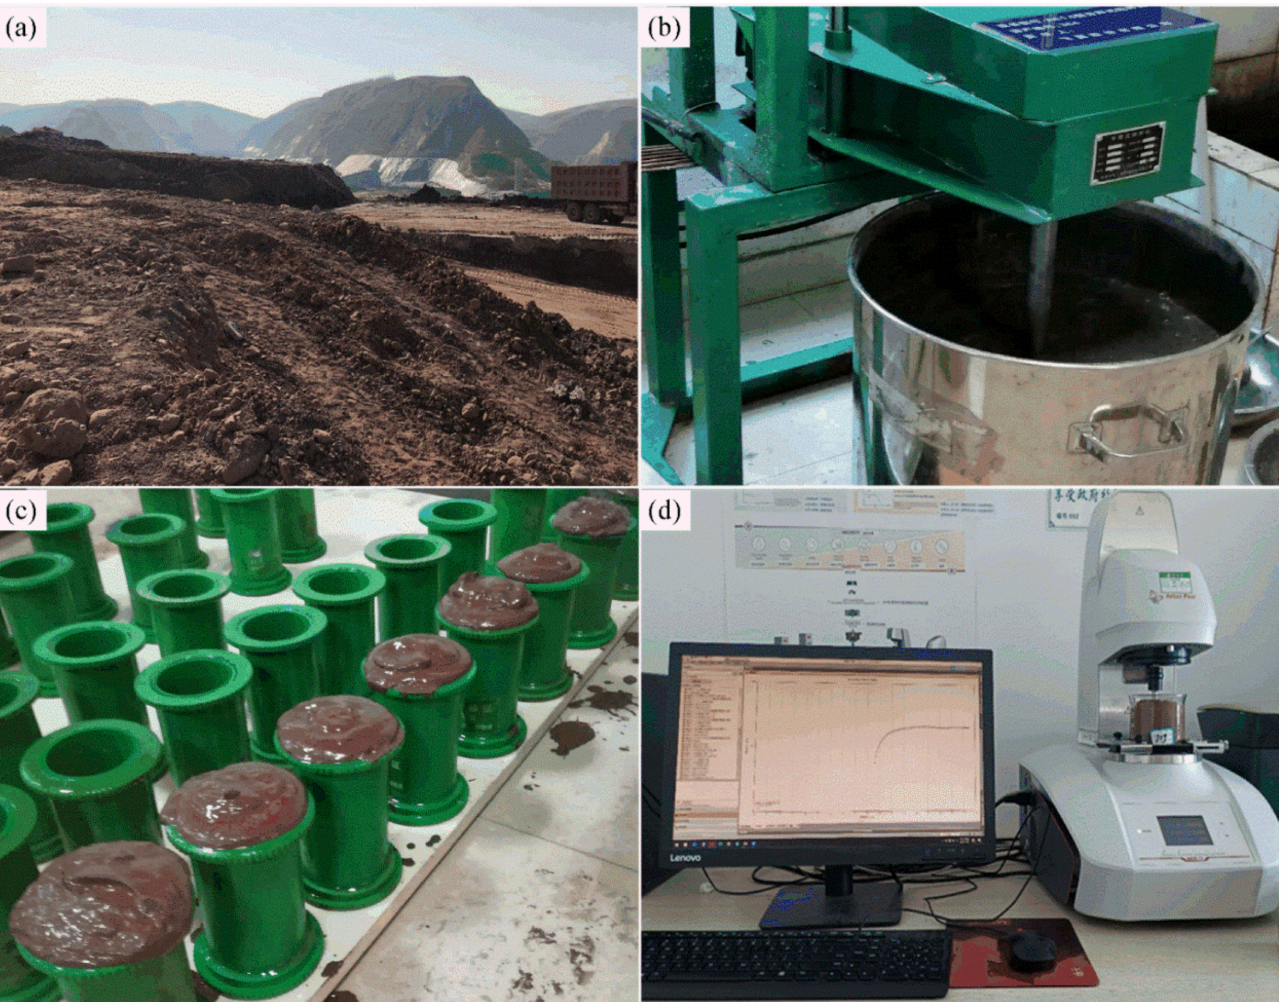
Figure 2. Tests of RMCB: ( a ) dry yard of BRM; ( b ) preparation of RMCB; ( c ) mixture proportion test; ( d ) shear rheological